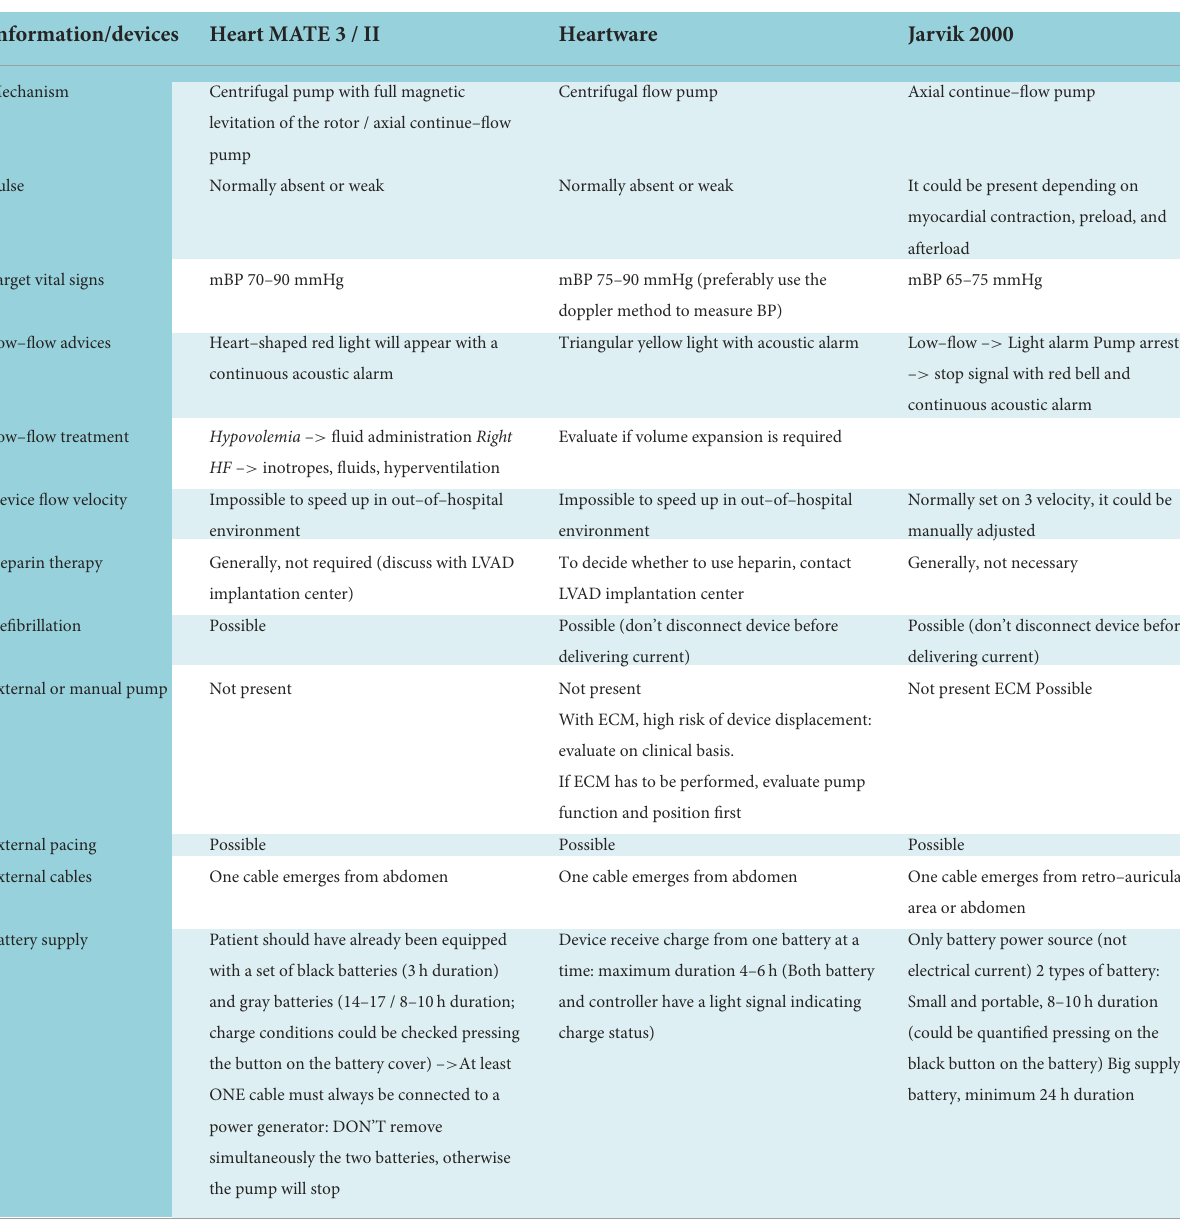
TABLE 3 Different LVAD device characteristics and subsequent different emergency